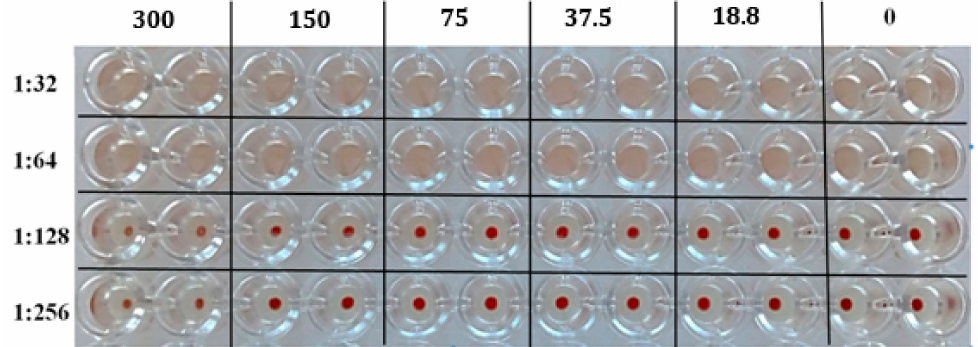
Figure 5. Effect of ginsamide on influenza virus-induced hemagglutination. Two-fold dilutions of influenza virus A/Puerto Rico/8/34 (H1N1) (indicated on the left) were incubated with ginsamide at a range of concentrations (0–300 µ g/mL) in the wells of round-bottom plates, and 1% chicken erythrocytes were added. The plates were incubated for 1 h at 20 ◦ C for sedimentation of